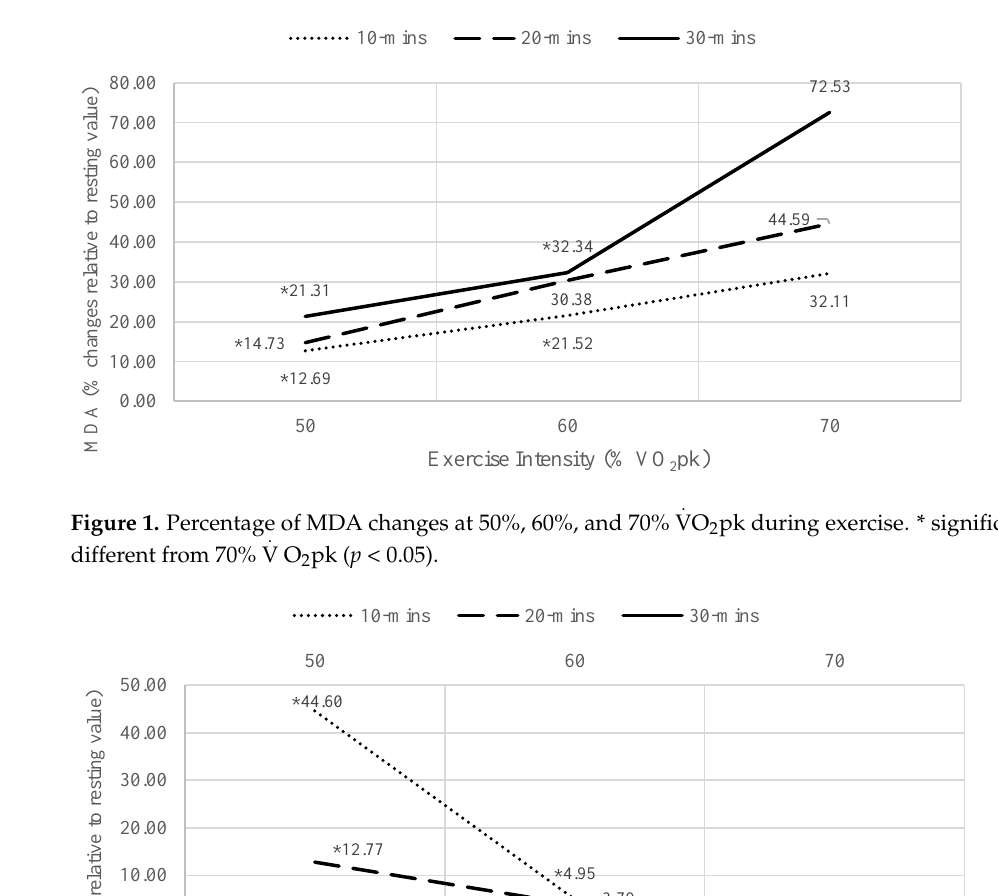
Figure 2. Percentage of CAT changes at 50%, 60%, and 70% V̇ O 2 pk during exercise. * significantly different from 70% V̇ O 2 pk ( p < 0.05).